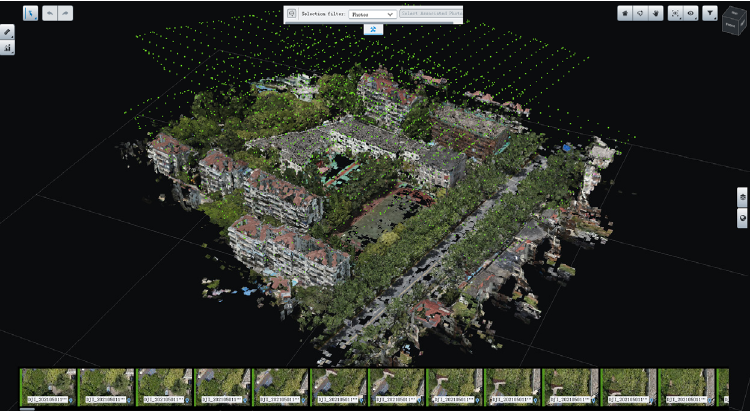
Figure 4. The sparse point cloud of M300RTK at a height of 50 m.